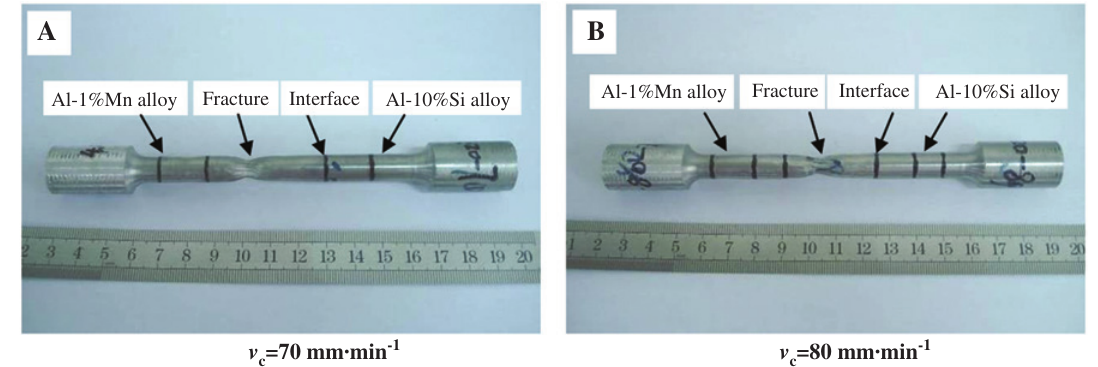
Figure 8: Tensile test results of clad slab under different casting speed: (A) 70 mm·min -1 and (B) 80 mm·min -1